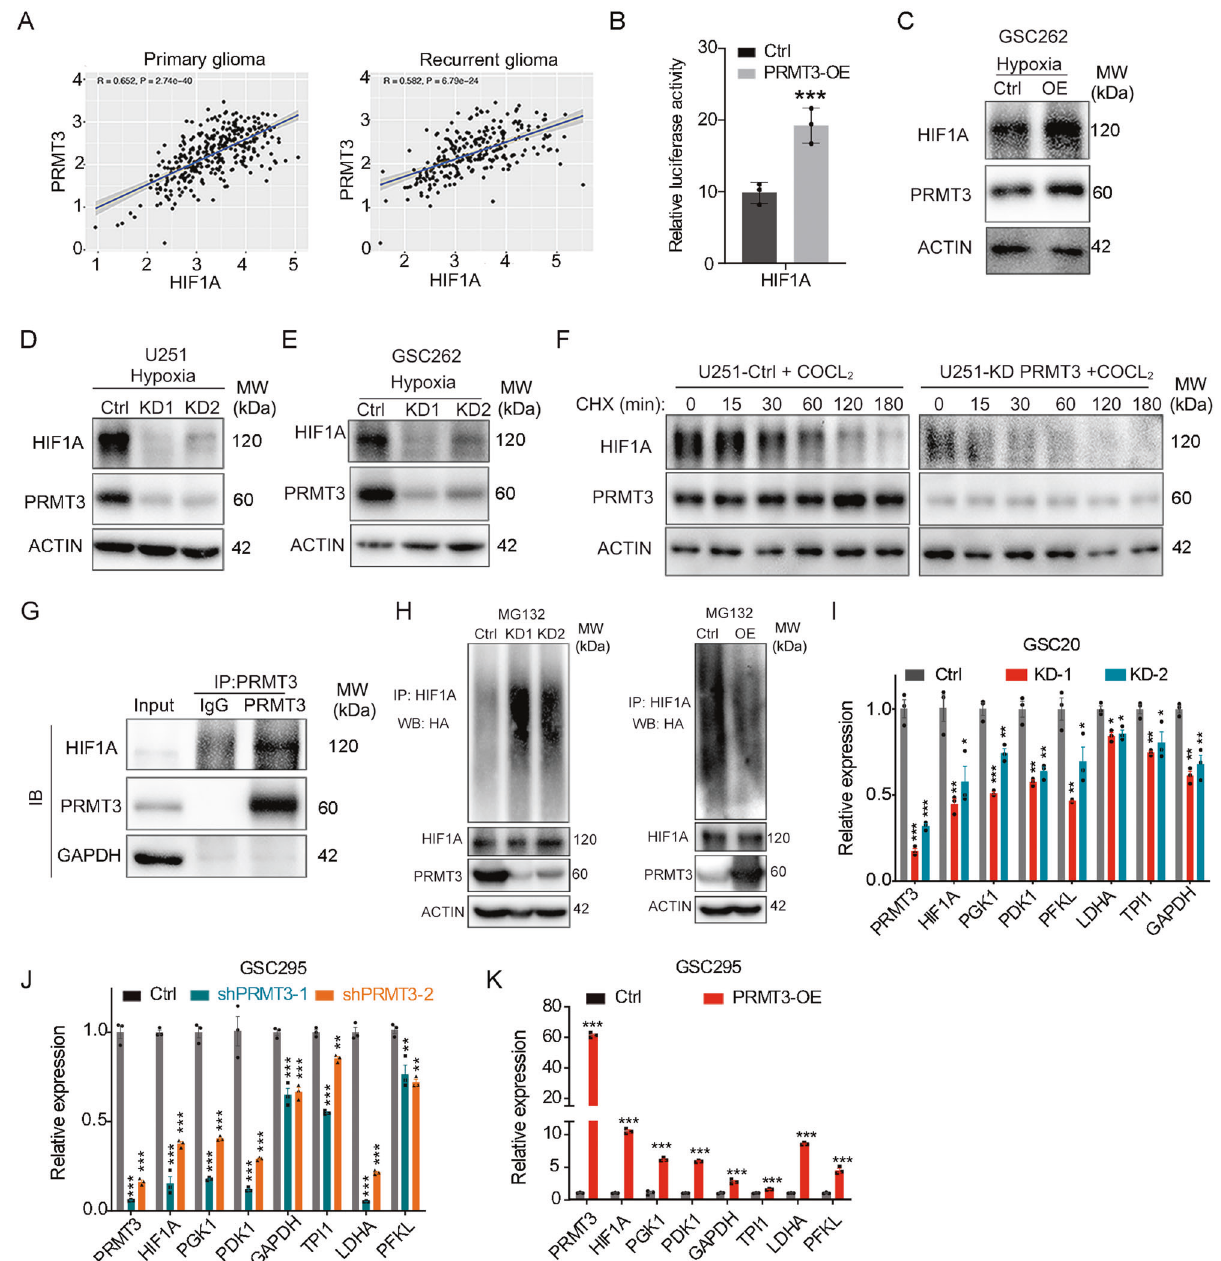
HIF1A reporter activity. Data are presented as means ± SEM; n = 3 independent experiments; *** p < 0.001; two-tailed unpaired Student t-test. C Representative western blots for HIF1A and PRMT3 in U251Ctrl cells and PRMT3-OE cells under hypoxia. ACTIN served as a loading control. D , E Representative western blots for HIF1A and PRMT3 in U251 ( D ) and GSC262 ( E ) Ctrl cells and PRMT3-KD cells under hypoxia. ACTIN served as a loading control. F The half-life of endogenous HIF-1 α detected by western blot after treatment with cycloheximide (CHX) under hypoxia. G CO-IP assay for the interaction of endogenous PRMT3 and HIF1A in the GSC262 cell line under hypoxia. H Representative western blots for poly-ubiquitin levels of HIF1A in 293 T PRMT3-KD (left) and PRMT3 overexpression (OE) (right) cells. ACTIN served as a loading control. I , J qRT- PCR analysis of the indicated genes in Ctrl and PRMT3-KD GSC20 ( I ) and GSC295 ( J ) cell lines. Data are presented as means ± SEM; n = 3 independent experiments; * p < 0.05, ** p < 0.01; *** p < 0.001; one-way ANOVA with multiple comparisons test. K qRT-PCR analysis of the indicated genes in Ctrl and PRMT3-OE GSC295 cells. Data are presented as means ± SEM; n = 3 independent experiments; *** p < 0.001; two- tailed unpaired Student